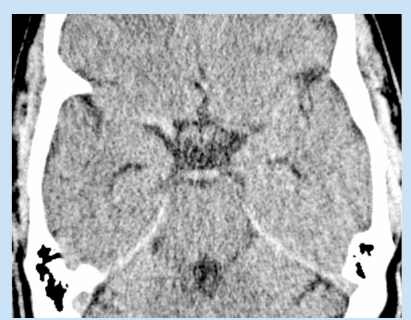
Fig .1a. Axial unenhanced CT scan showing the hyperdense appearance of the terminal right ICA and proximal MCA.